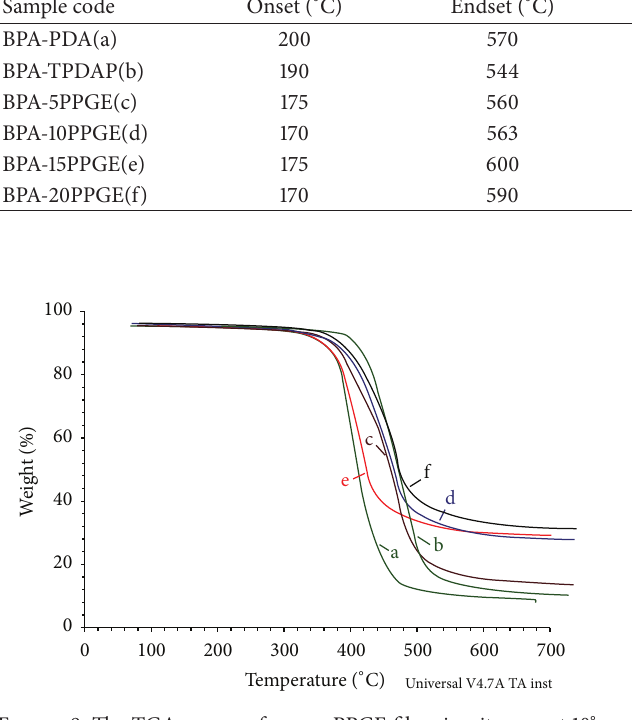
Figure 9: The TGA curves of epoxy-PPGE films in nitrogen at 10 ∘ (C/min) heating